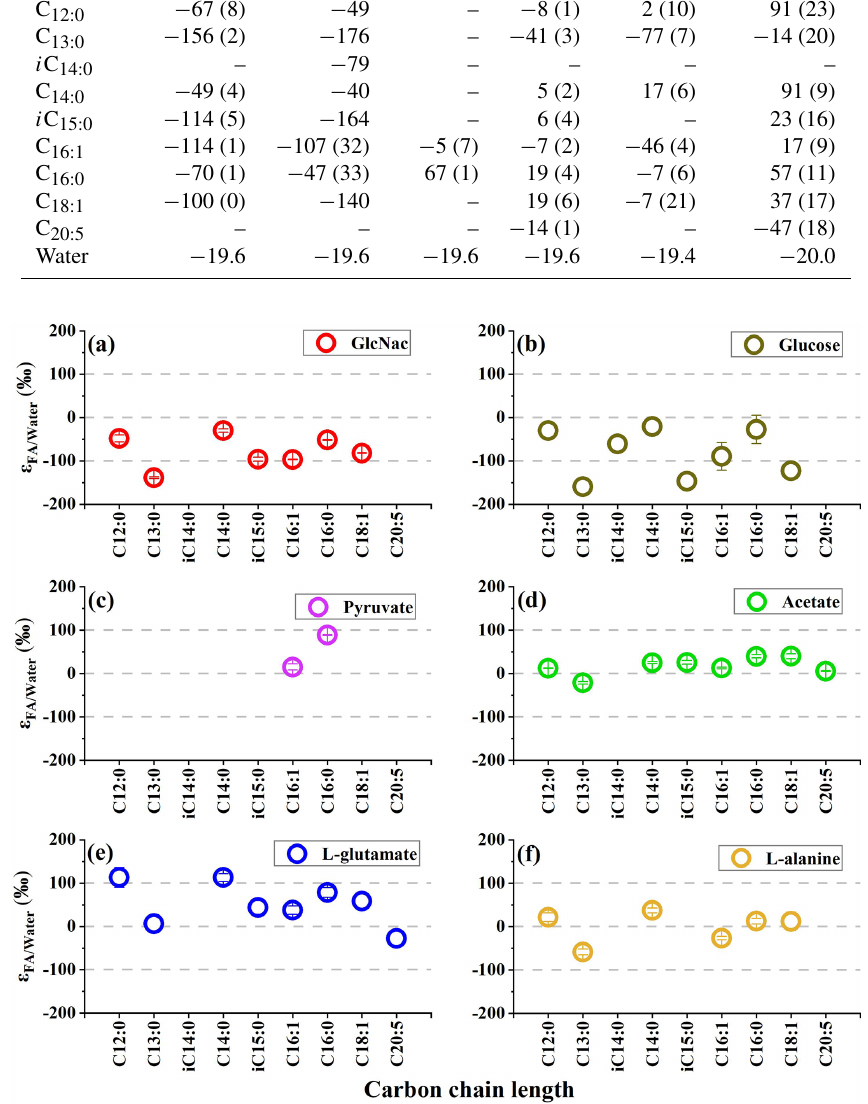
Figure 1. The hydrogen isotope fractionation between fatty acids and growth water in S. piezotolerans WP3 growing on different substrates including GlcNac, acetate, D-glucose, pyruvate, and amino acids at 20 ◦ C and shaking at 200rpm. The error bars represent the 1 σ standard deviations of duplicate